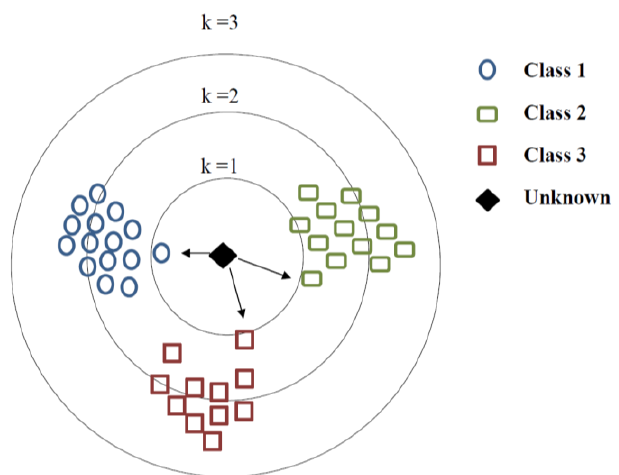
Figure 4. A pictorial view of the k-nearest neighbor working principle.